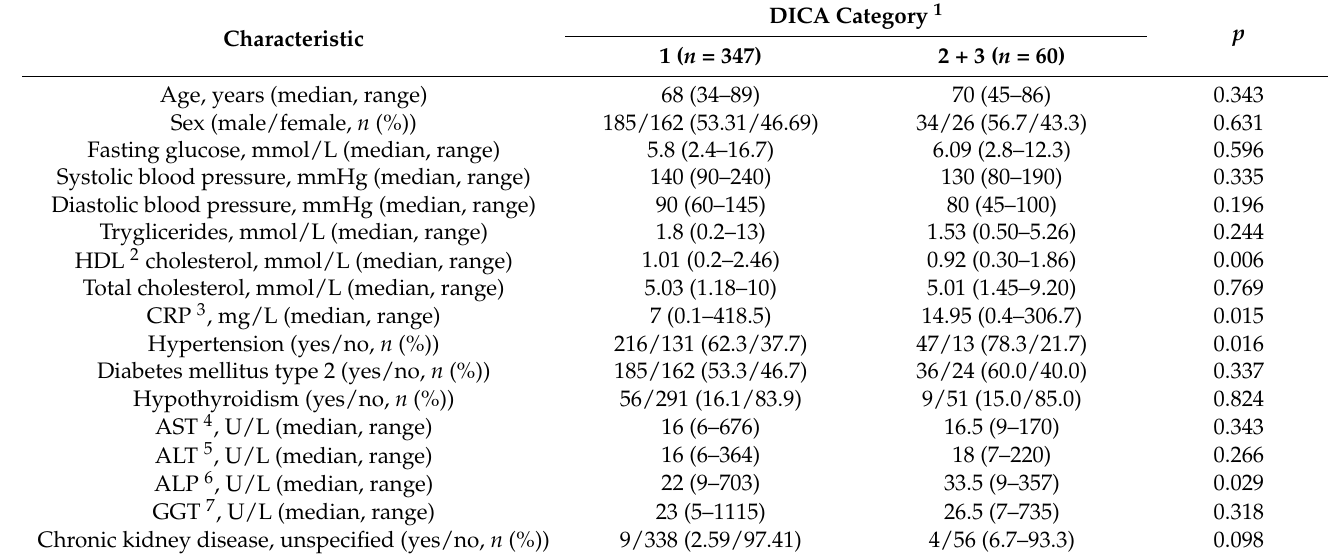
Table 2. Characteristics of the study population concerning the severity of colonic diverticulosis.